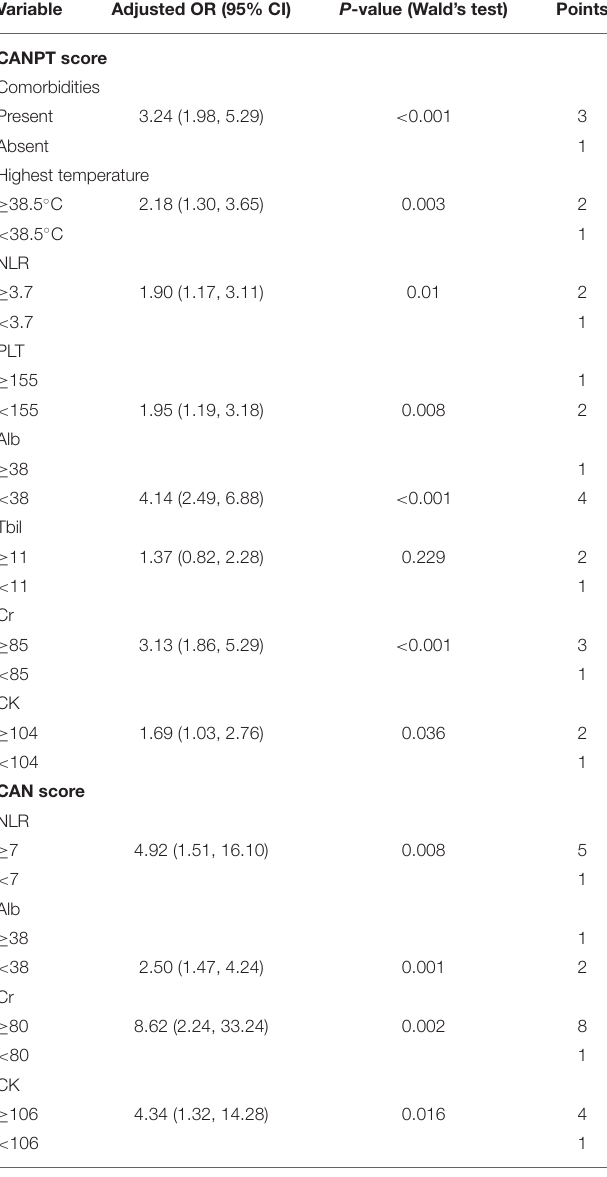
TABLE 4 | Calculation of the CANPT and CAN scores. TABLE 5 | Accuracy of the CANPT score in estimating the risk of disease